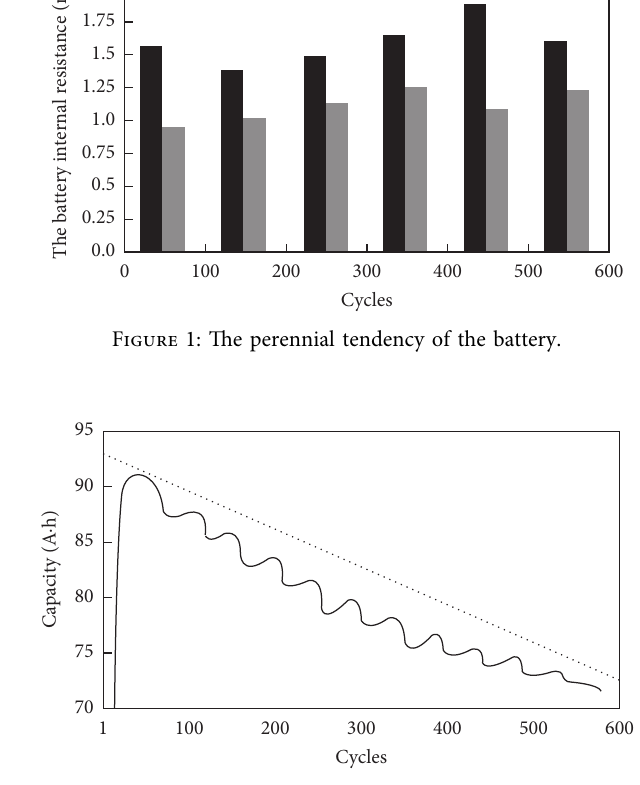
Figure 2: Variation trend of battery capacity under different aging